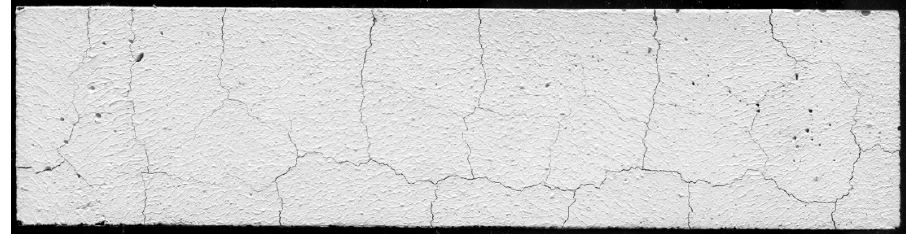
Figure 3. Cracking pattern on the surface of the cement matrix with MWCNTs (C52CNT) with w/c = 0.4.